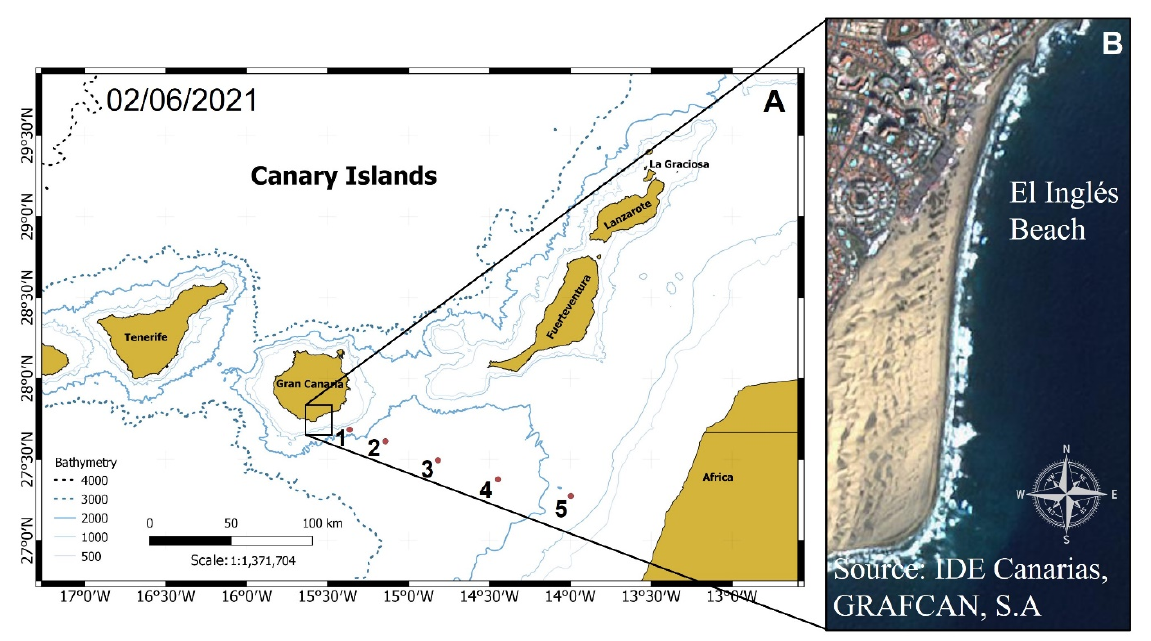
Figure 1. Location of stranded mesopelagic fishes along “El Inglés” Beach (Gran Canaria Island, Spain). ( A ) Map of the eastern islands of the Canarian Archipelago. Numbers on the map are the locations where oceanographic variables were examined. ( B ) Source: IDECanarias, GRAFCAN, S.A. Canary Islands Government (2021).